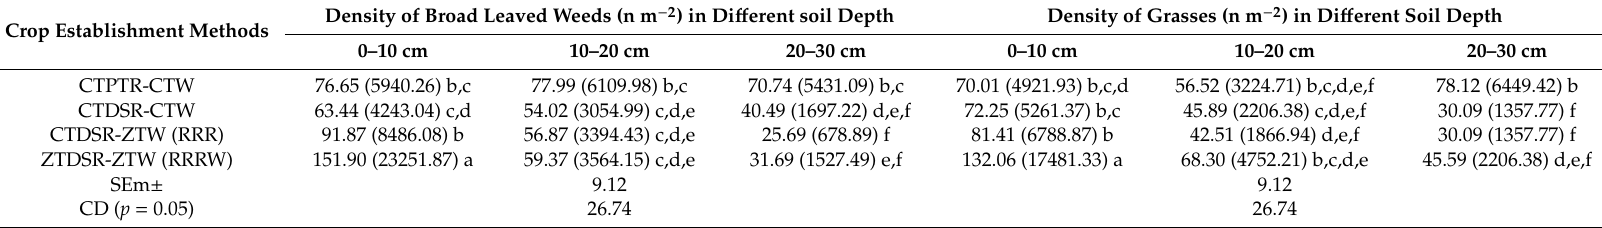
Table 5. E ff ects of crop establishment methods and soil depth on the seed bank of BLWs and grassy weeds. Crop Establishment Methods